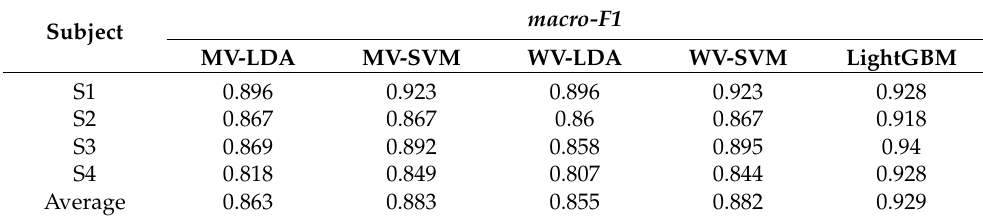
Table 8. The macro-F1 score results for the five ensemble learning